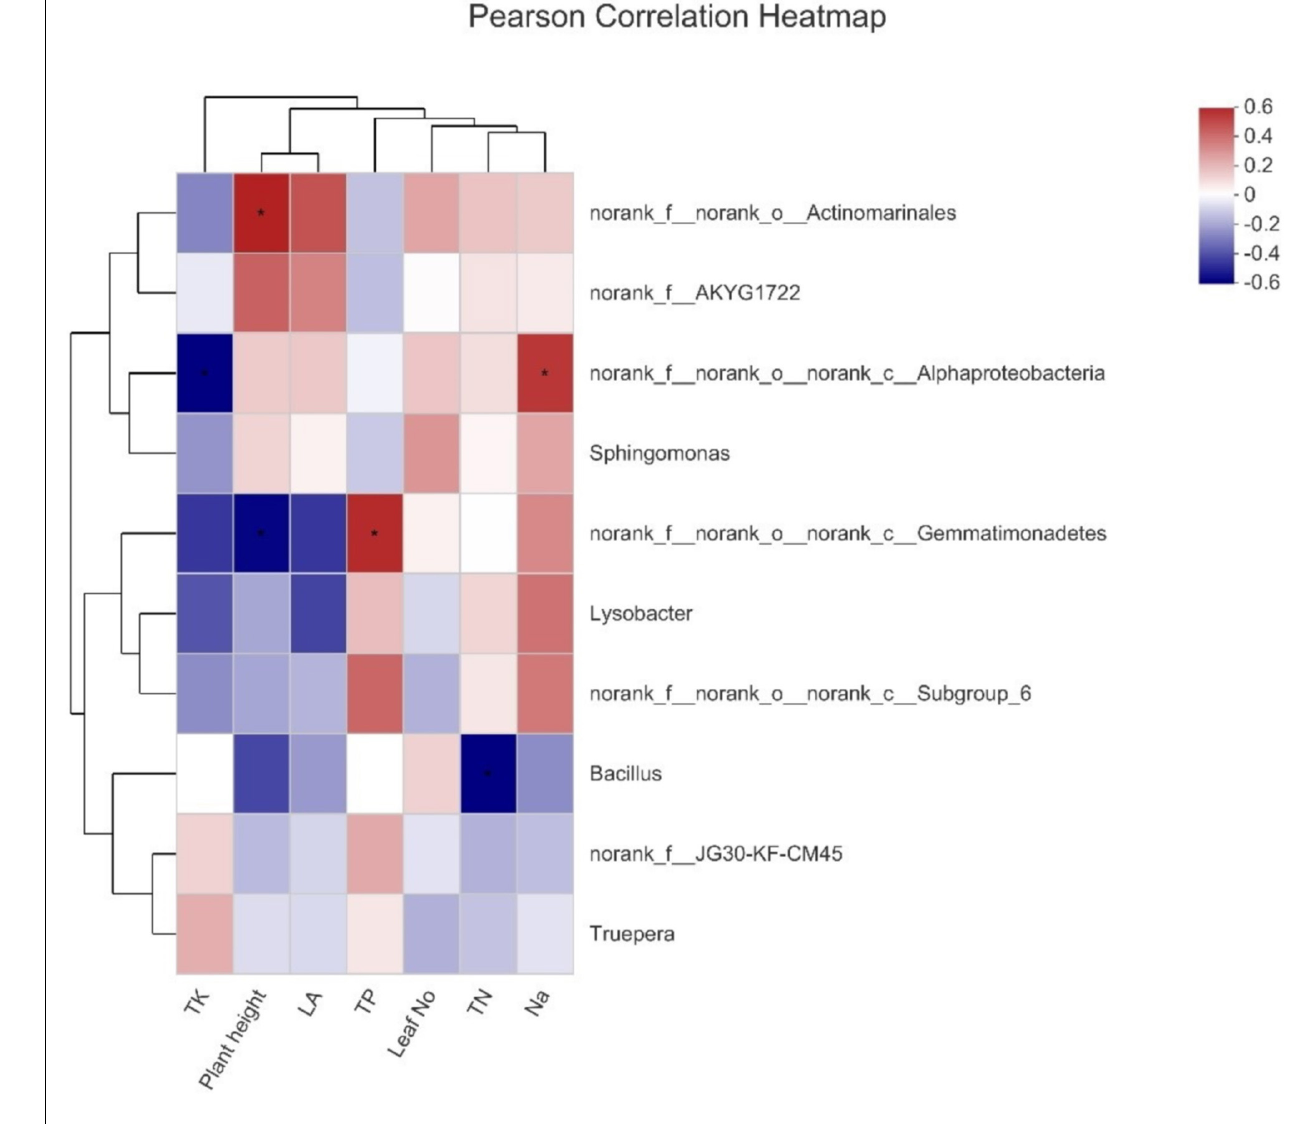
FIGURE 5 | Pearson correlation coefficients among nutrients and bacteria